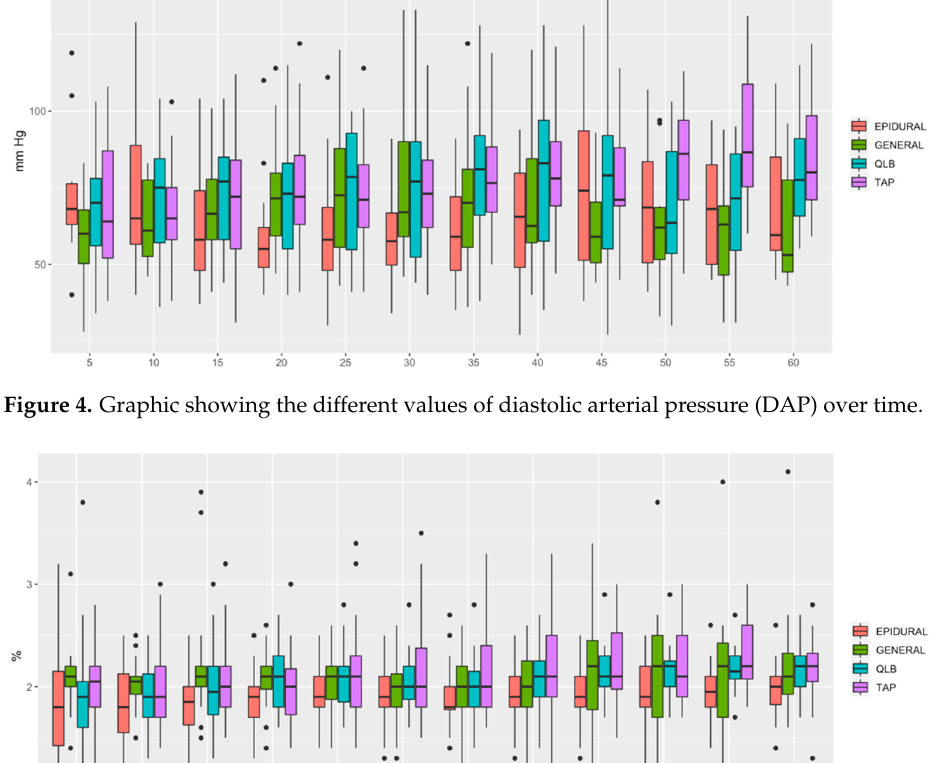
Figure 3. Graphic showing the different values of systolic arterial pressure (SAP) over time.